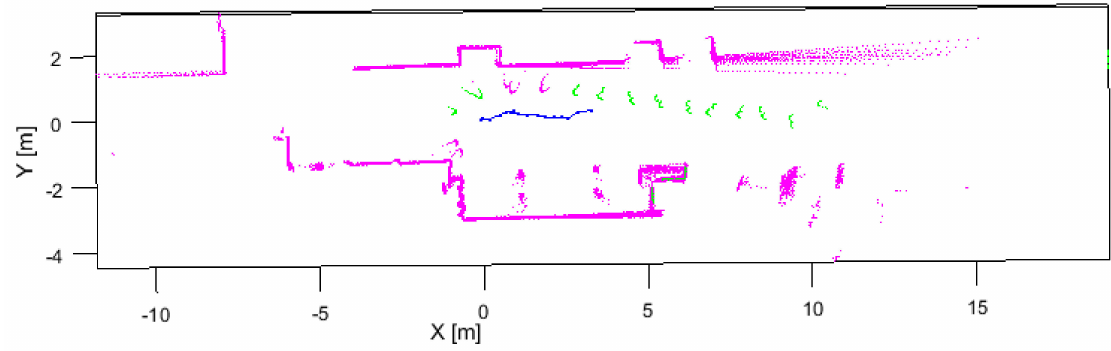
Figure 12. Map with identified dynamic